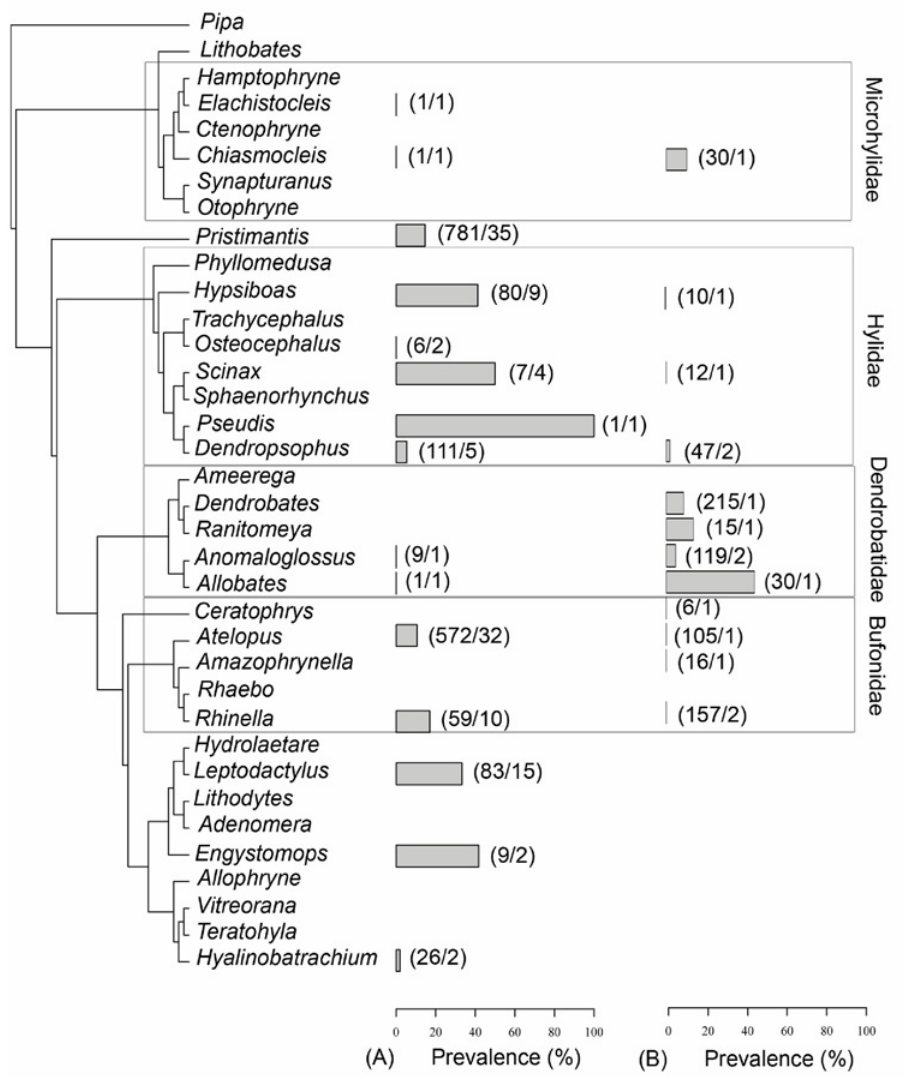
Fig 3. Measure of Bd prevalence for anuran genera. (A) Mean prevalence for the genus as reported in Bd- maps and (B) Mean prevalence for the genus measured in this study. Values in bracket indicate the total number of individuals sampled and the number of species sampled for the genus (Number of individuals/ Number of species). The phylogenetic tree (topology) is based on Pyron et al. (2011) adapted according to Fouquet et al.